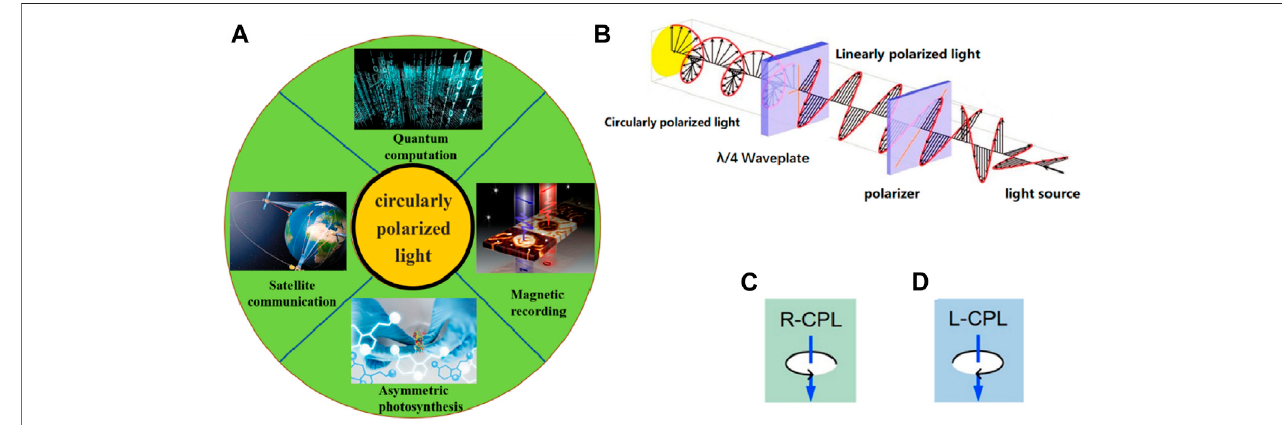
FIGURE 1 | (A) Various applications of CPL, such as quantum computations, satellite communication, asymmetric synthesis, and magnetic recording. (B) Schematic diagram of the experimental setup to generate CPL. According to the rotation direction of the light vector, circularly polarized light is divided into (C) Right - handed CPL and (D) Left - handed